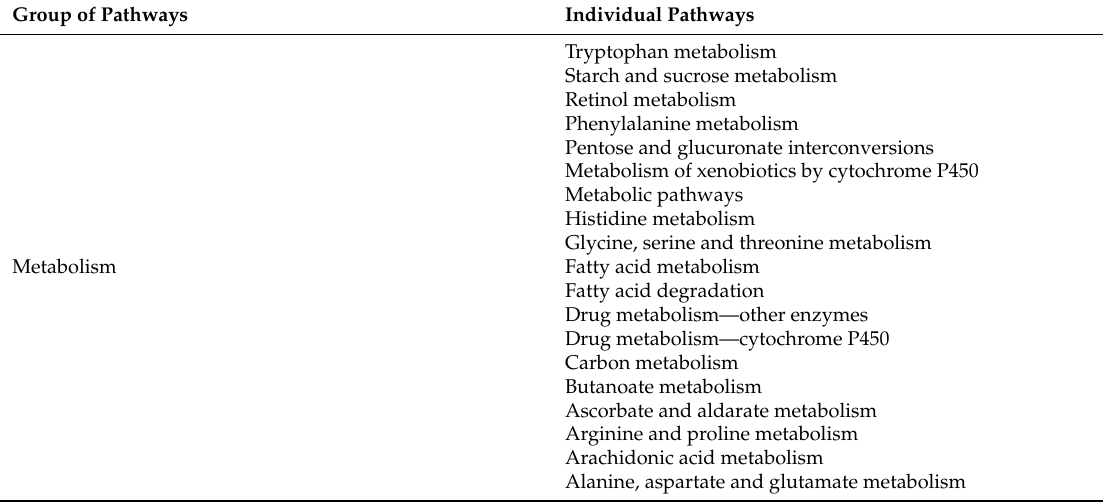
Figure 4. Venn diagram of ( A ) up- and ( B ) downregulated genes in Wilms tumor compared to normal kidneys. Table 3. Kyoto encyclopedia of genes and genomes (KEGG) pathways enriched for potential target genes of deregulated miRNAs in